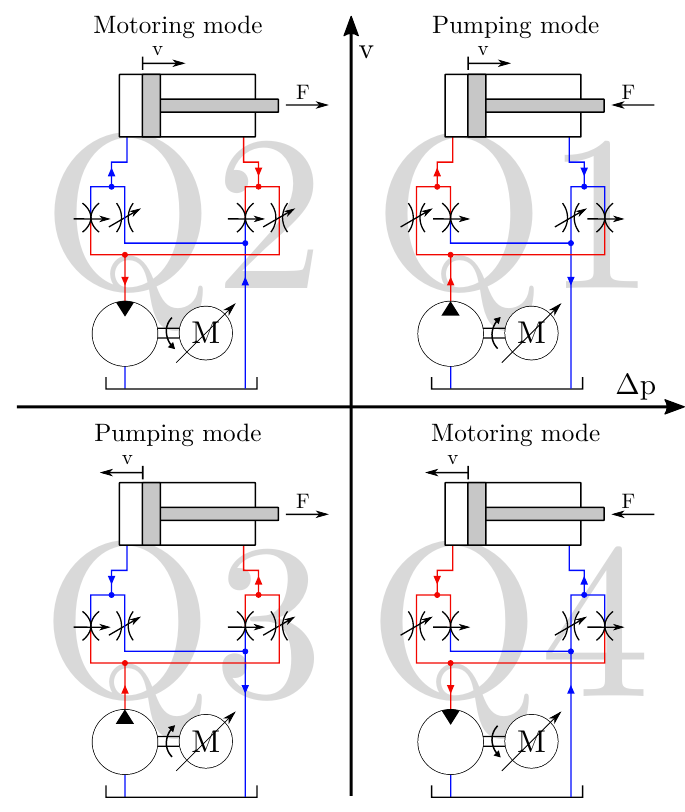
Figure 3. Working modes for a generalised open circuit